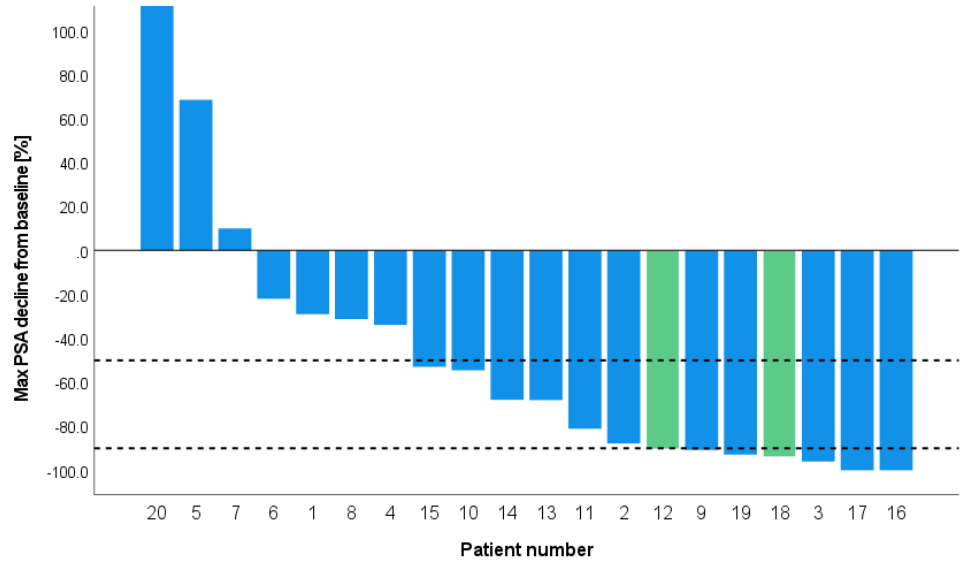
Figure 2. Waterfall plot of the individual changes of best PSA-response following PSMA − RLT. Blue bars indicate patients treated with 177 Lu − PSMA and green bars with 177 Lu − PSMA and 225 Ac − PSMA. The two black lines represent ≥ 50% and ≥ 90% PSA decline. mHSPC = metastatic hormone sensitive prostate cancer; PSA = prostate specific antigen; PSMA = prostate specific membrane antigen; RLT = radioligand therapy.